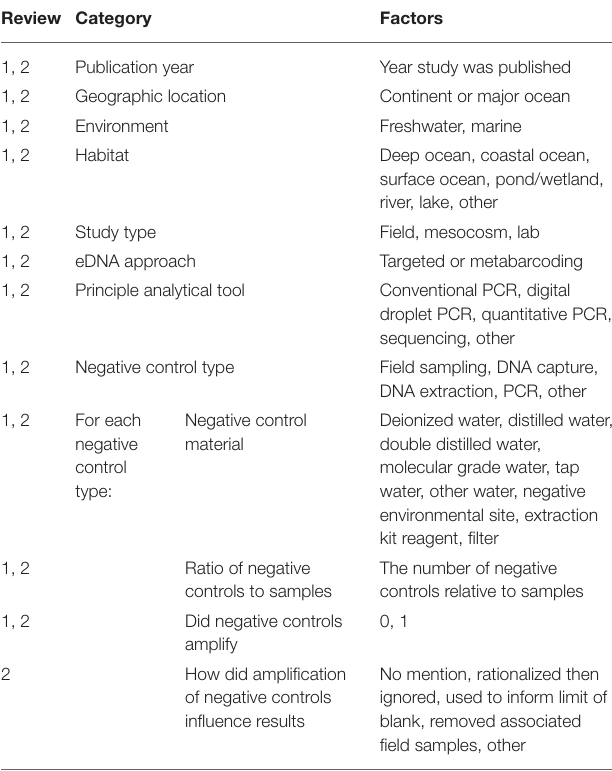
TABLE 1 | The occurrence of factors within each category was recorded for all studies in Literature Review #1 or